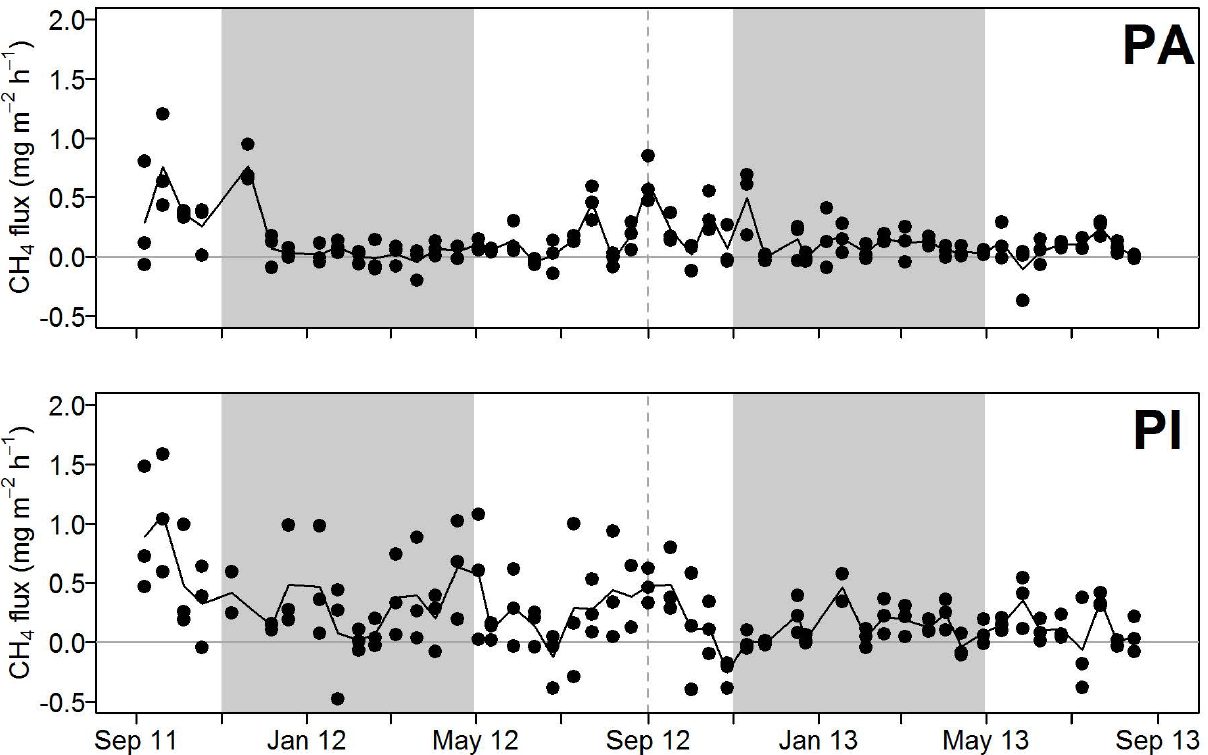
Figure 3. Methane fluxes (mg m -2 h -1 ) of the two production strips with S . palustre (PA) and S. papillosum (PI) during the establishment phase. Individual flux values (solid circles) are shown together with the mean of each measurement day (black line). The main growing seasons (May to October) are indicated by a grey background.